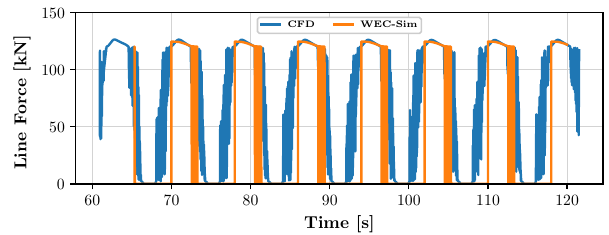
Fig. 11. The WEC is restricted in 3 DoF motion. The plot represents the time series of the connection line force.